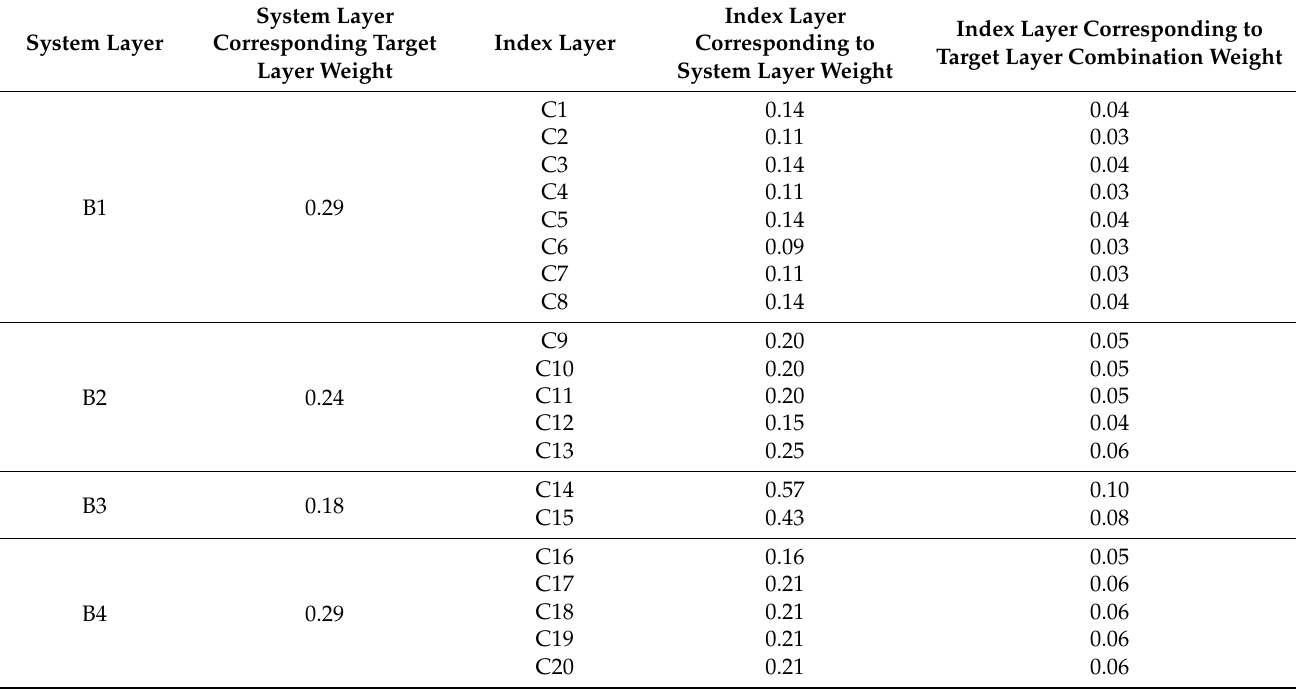
Table A9. Evaluation index weights for WRCC of